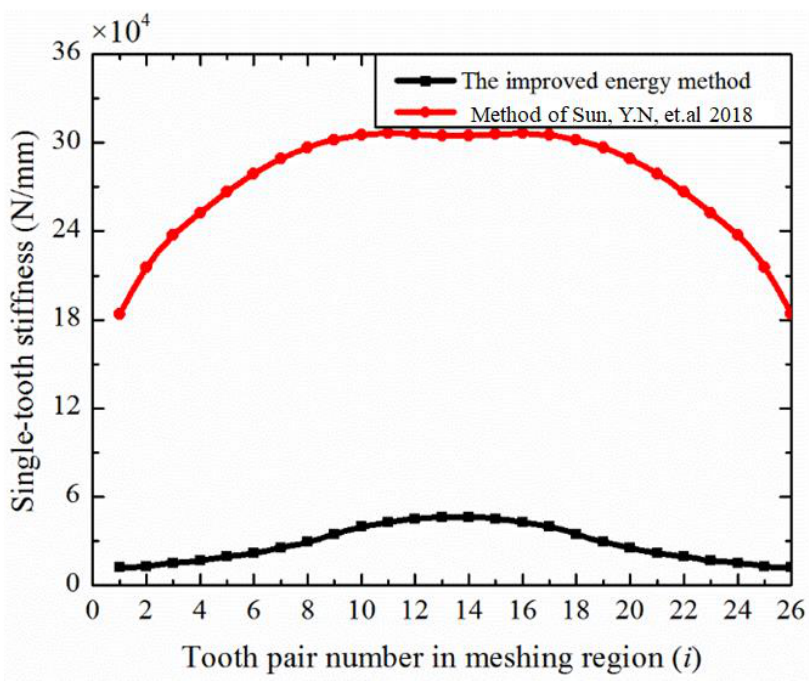
Figure 13. Single-tooth stiffness obtained by two analytical methods [10].